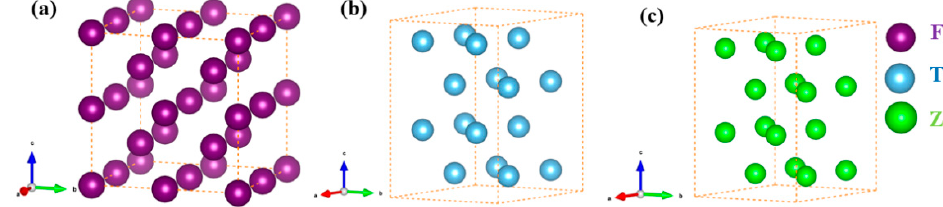
Figure 1. Crystal structure of ( a ) Fe, ( b ) Ti, and ( c ) Zr.